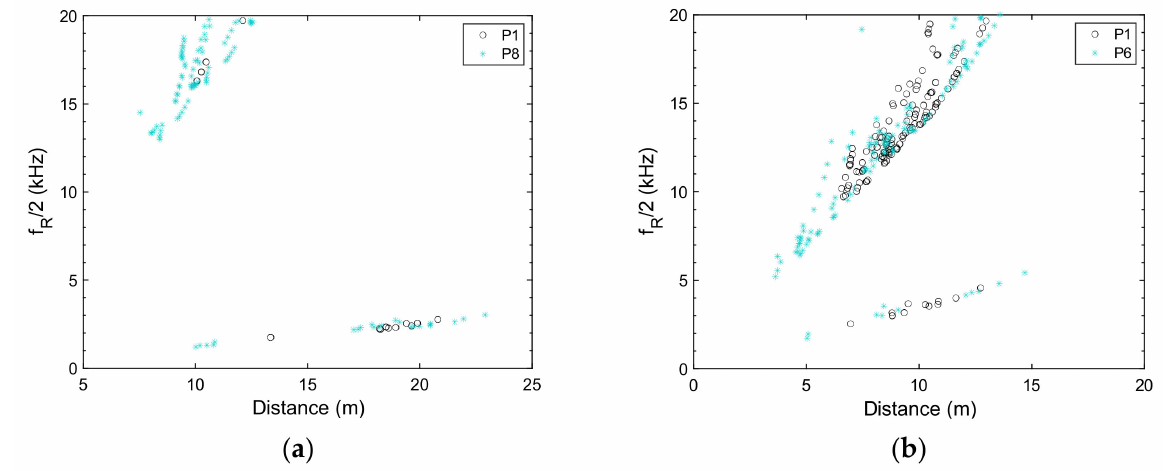
Figure 7. Calculated values of f R /2 based on Equation (1) for individual equivalent reflectors: ( a ) Panna Meena ka Kund (full model, Positions 1 and 8); ( b ) Lahan Vav (Positions 1 and